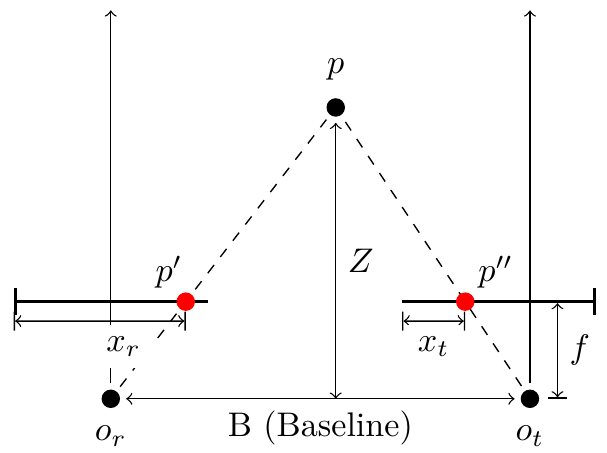
Figure 6. Binocular stereo vision